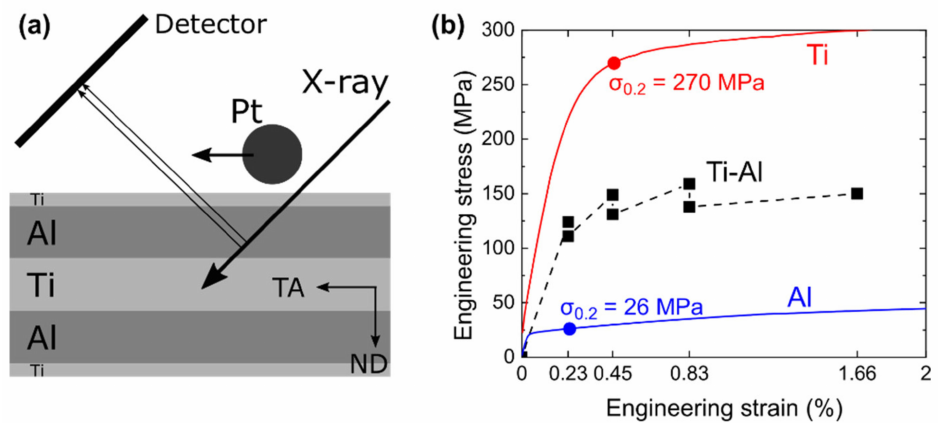
Figure 1. Schematic view of the experimental setup for the monochromatic differential aperture X-ray microscopy (DAXM) experiment, where transverse direction (TD) is out of plane ( a ) and the interrupted tensile loading of the Ti-Al laminated metal composites (LMC) together with tensile curves for Ti and Al after the same thermomechanical treatment ( b ). Adapted from